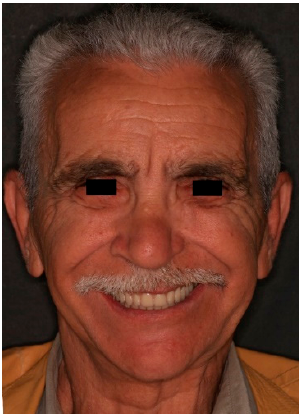
Figure 6. Tracing of the pharyngeal extension of the maxillary prosthesis.